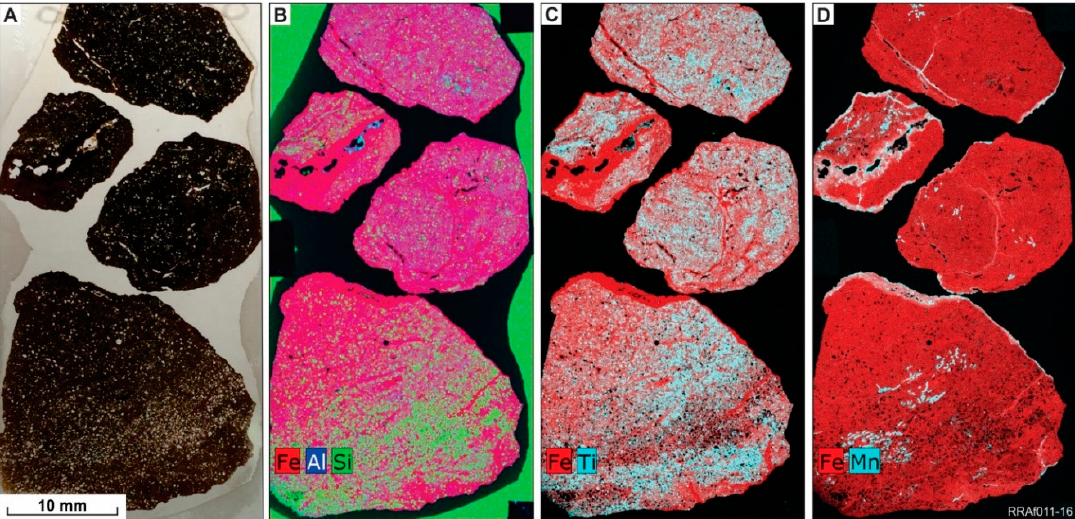
Figure 11. ( A ) Photograph of a polished thin section of ferruginous nodules formed in the Wollubar Sandstone (NWS). ( B – D ) Bruker XRF elemental maps for Fe, Al and Si, Fe and Ti and Fe and Mn. Pink colour in image B is a combination between red for Fe and blue for Al.